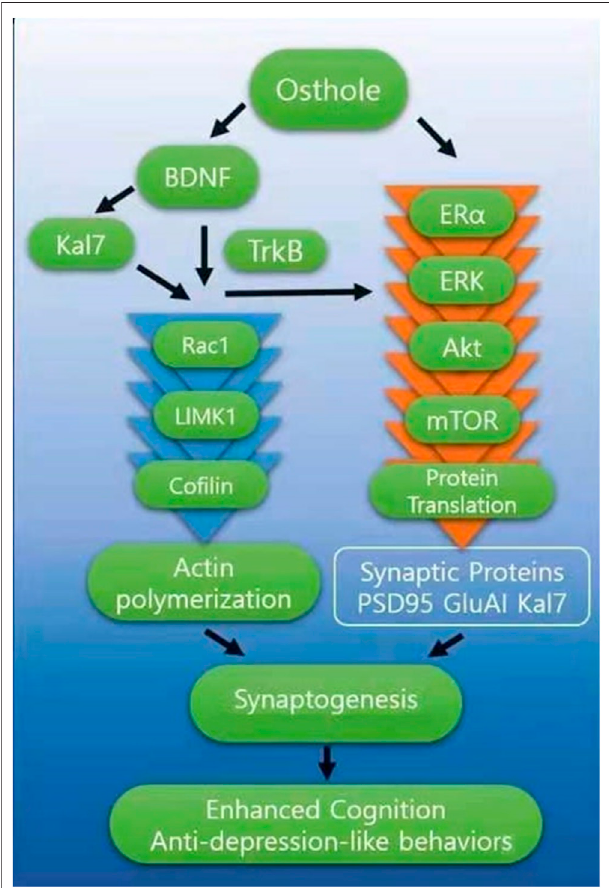
FIGURE 7 | The fi gure above summarizes the effects of OST in OVX mice. Chronic OST treatment led to changes in the levels of synaptic proteins in the hippocampus and at least some of these effects require BDNF/TrkB signaling. OST interacts with BDNF and ER α , leading to activation of downstream signals to improve cognitive impairment and ameliorate depression-like behaviors observed in OXV mice. OST caused increase in the release of BDNF, which then binds to and activates its surface receptor, TrkB then activates oneofits twomajor downstreamsignaling cascades, ERK-Akt. This pathway converges onto the mammalian/mechanistic target of rapamycin(mTOR),akeyregulatorofproteinsynthesisandsynapticplasticity. This event leads to disinhibition of synaptic protein translation (e.g., GluA1, PSD95,Kal7),whichleadstosynaptogenesis.The interaction of BDNF with Kal7 also in fl uenced the Rac1/LIMK1/Co fi lin pathway. OST-mediated changes in the levels of Rac1 also suggest that OVX-induced perturbation of hippocampal synaptic connectivity was reversed by treatment with OST, through functional modi fi cations of neuronal networks in the brain. This suggests that the effects of OST on hippocampus-related behavior is in part due to the effects on the connectivity of neurons in this brain